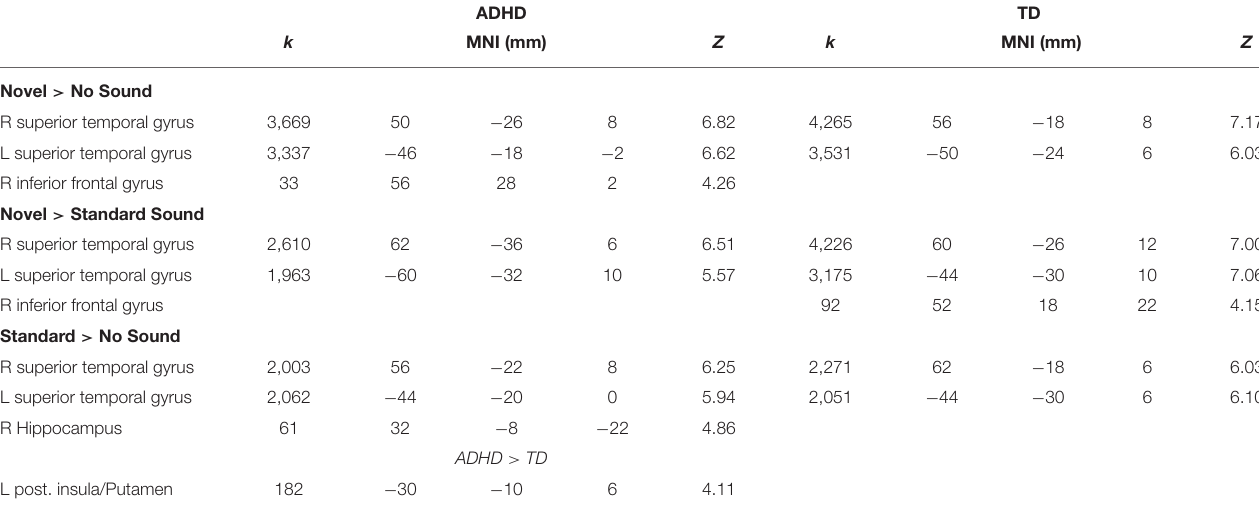
TABLE 2 | Activation peaks (FDR corrected, p < 0.05) of group-wise and between group comparisons for sound related changes in brain activity during task performance in children and adolescents with ADHD and without (TD).